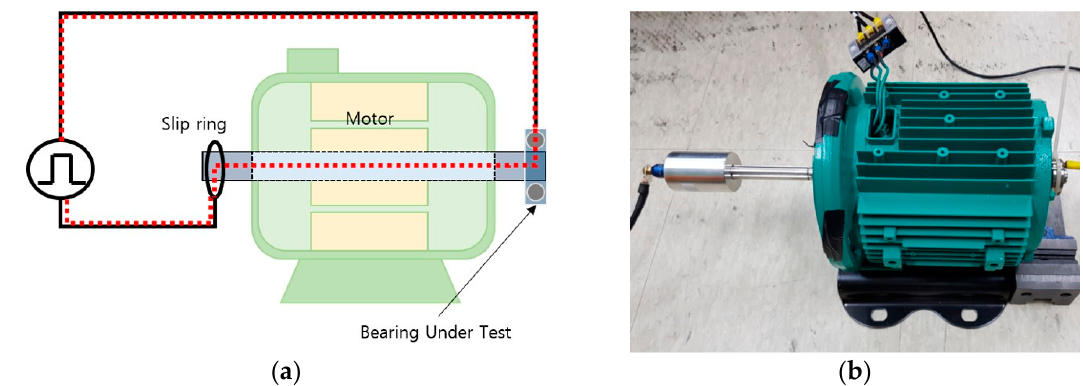
Figure 6. Mechanism of the damaging bearing using electrical stress: ( a ) schematic diagram of the mechanism; ( b ) experimental setup.